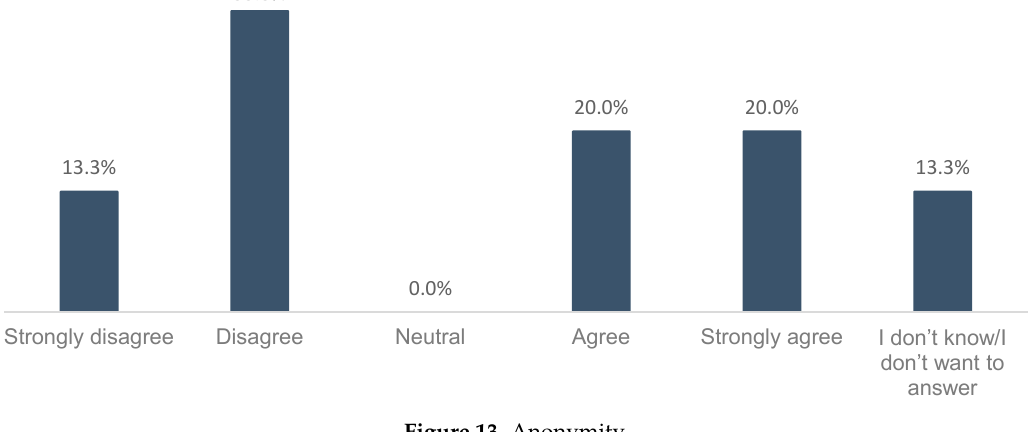
Figure 13. Anonymity.